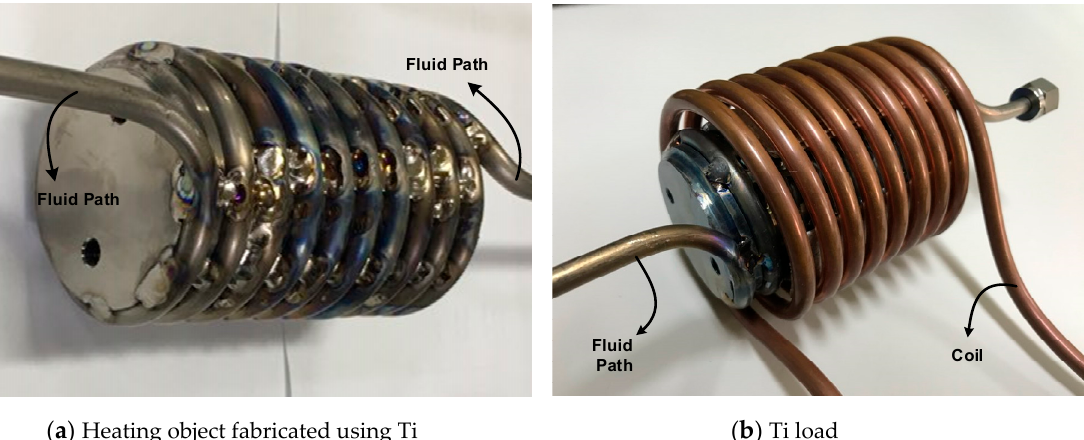
Figure 7. Proposed titanium (Ti) load structure of the cleaning equipment.